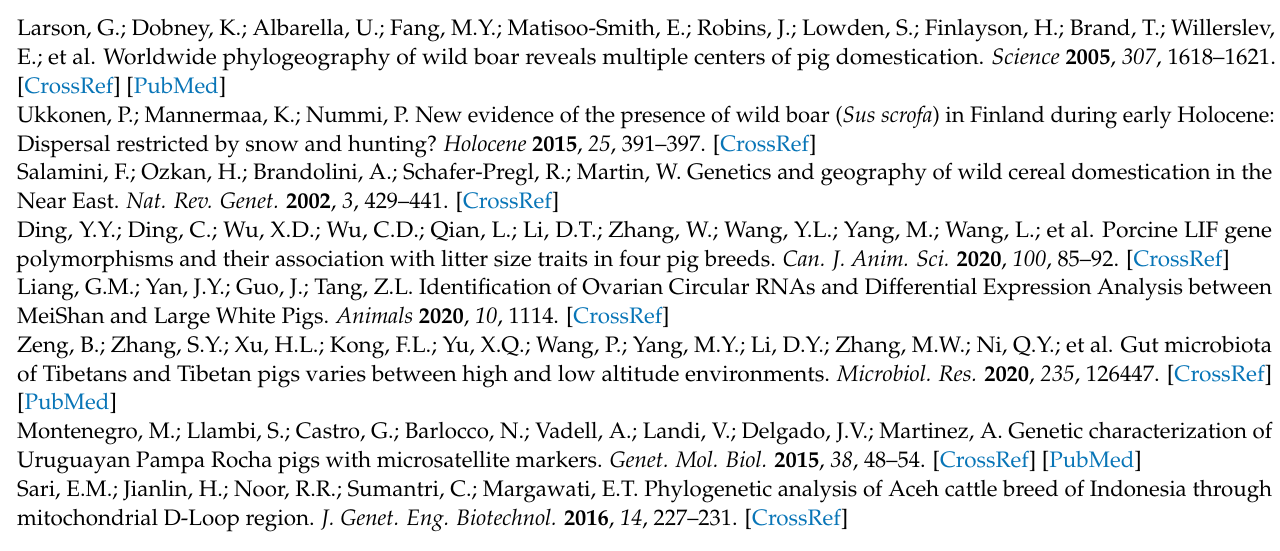
Table S3: GO enrichment analysis of candidate genes in selected regions of Anqing six-end-white pig (AQ pig); Table S4: KEGG enrichment analysis of candidate genes in selected regions of Anqing six-end-white pig (AQ pig); Table S5: The QTLs mapping